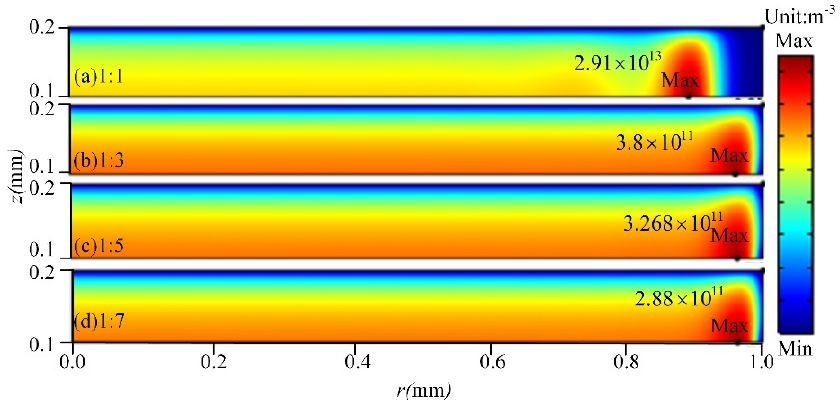
Figure 7. The spatial distribution of positive ions.